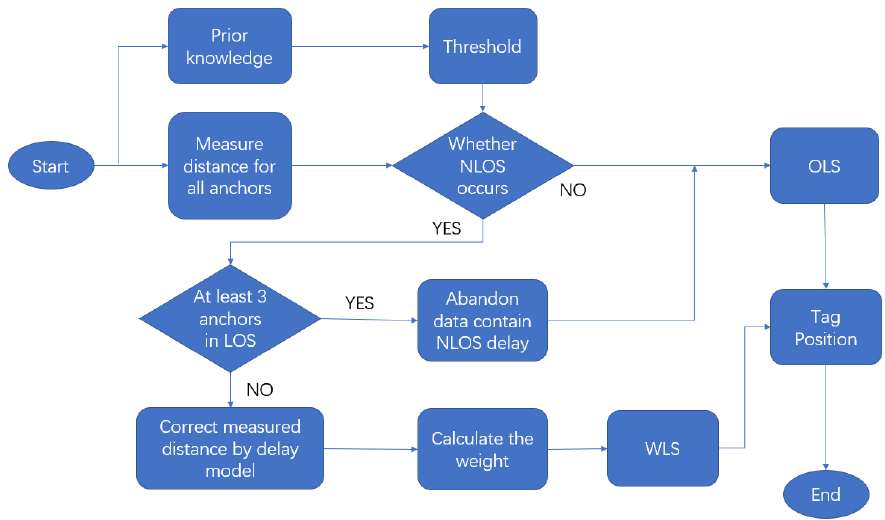
Figure 1. Flowchart for the proposed method.